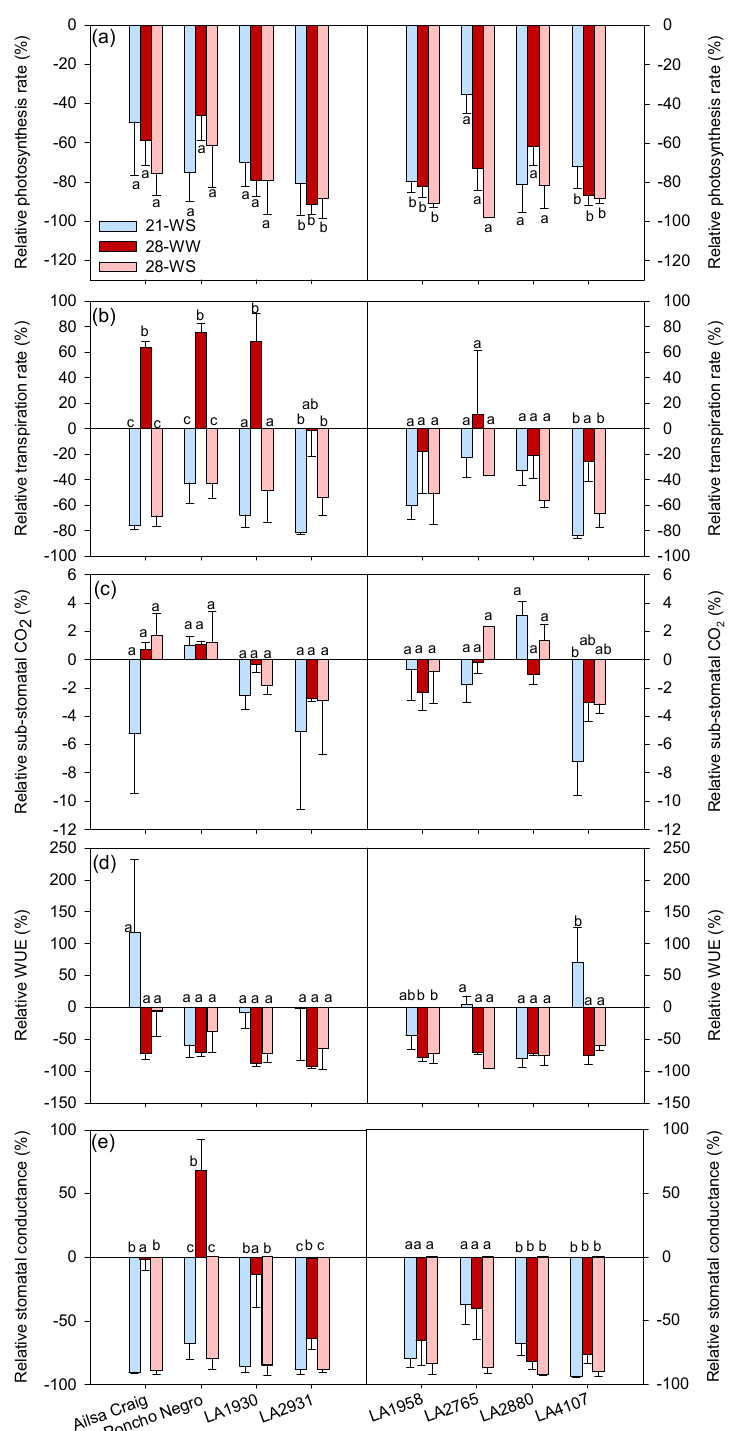
Figure 5. Effect of temperature and water stress on ( a ) photosynthesis rate (A), ( b ) transpiration rate (E), ( c ) substomatal CO 2 concentration (Ci), ( d ) water use efficiency (WUE), and ( e ) stomatal conductance (gs) of S. lycopersicum cultivars and S. chilense populations: relative values to the control condition (21-WW) for each accession. Plants were grown at 21 °C under well-watered (21-WW) and water-stressed (21-WS) conditions or at 28 °C under well-watered (28-WW) and water-stressed (28-WS) conditions. Treatments followed by different letters are significantly different at p < 0.05 for the same accession (considering that the control plants are a). Data ± SE.